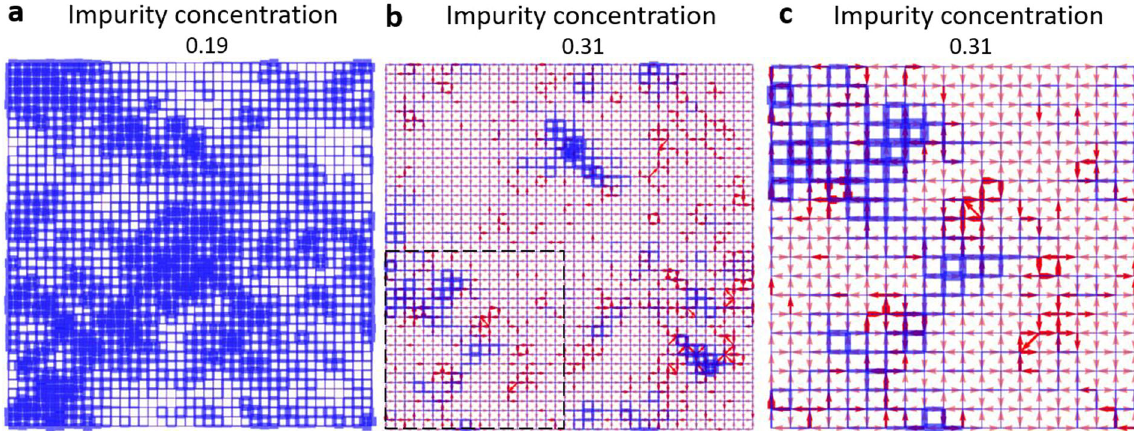
Fig. 5 Equilibrium current loops. The blue-colored bonds represent the absolute value of the d -wave pair fi eld. The red arrows represent the spontaneously generated super-current. The thickness of the arrow denotes the magnitude of the current. The impurity concentration is 0.19 in ( a ) and 0.31 in ( b ). No detectable current exists (smaller than 10 − 12 ) in ( a ) while they are quite apparent for ( b ). c Zoom-in view of the lower- left corner indicated by the black dashed line in panel ( b ). For clarity, only when the magnitude of current is >0.001 (which is ~2/10 of the maximum current value) do we plot a dark red arrow. For smaller current values we use pink arrows to represent